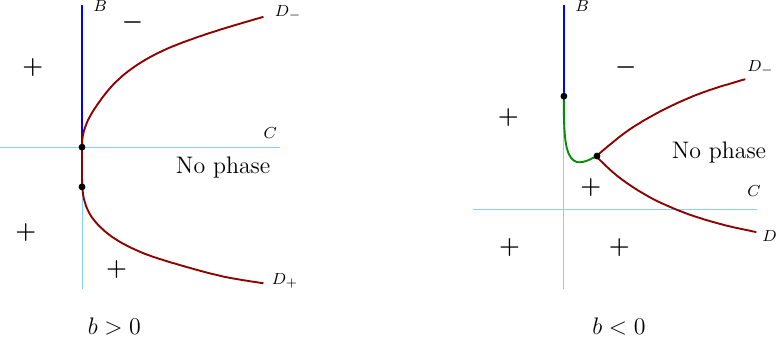
Figure 26 . Phase diagram for Case I: A > 0 , A + a > 0 . The solid blue line is a second order phase transition between the − and + phases. The solid red lines demarcate regions of monotonic potential. The solid green line is a first order phase transition line between the − and + phases. 2. C < 0 : in figure 24(e). There is always a minimum in the − branch and a maximum in the + branch, irrespective of the values of the parameter B